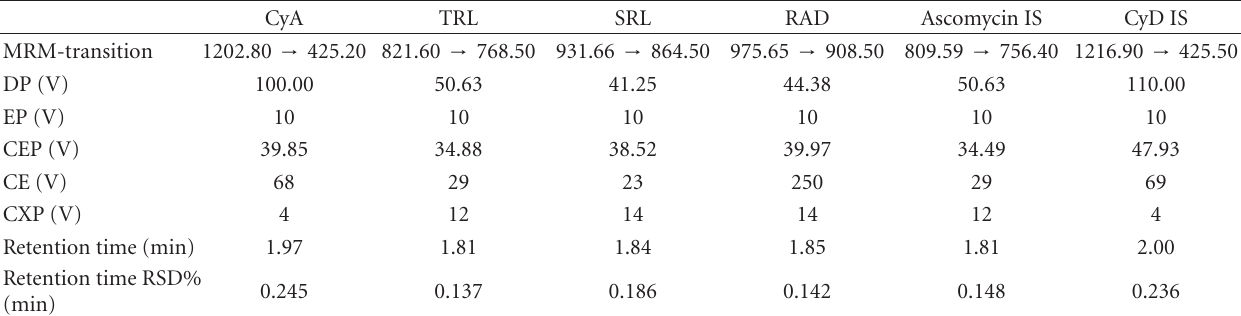
Table 2: LC-MS/MS parameters (MRM transition, DP, EP, CEP, CE, and CXP) and retention times of four immunosuppressive drugs and internal standards.